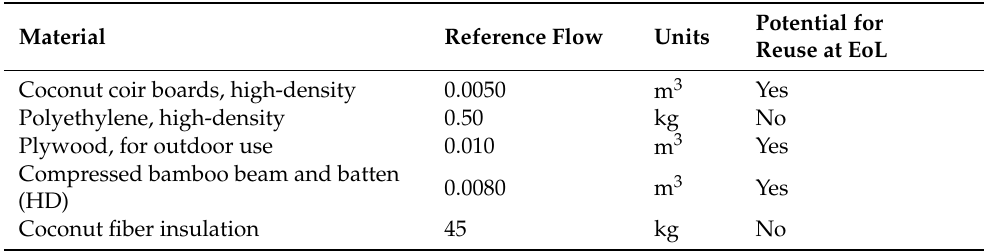
Table 4. Bill of materials for 1 Functional Unit (FU = 1 m 2 ) of coconut-based wall assembly. Reference flow = amount of material required per